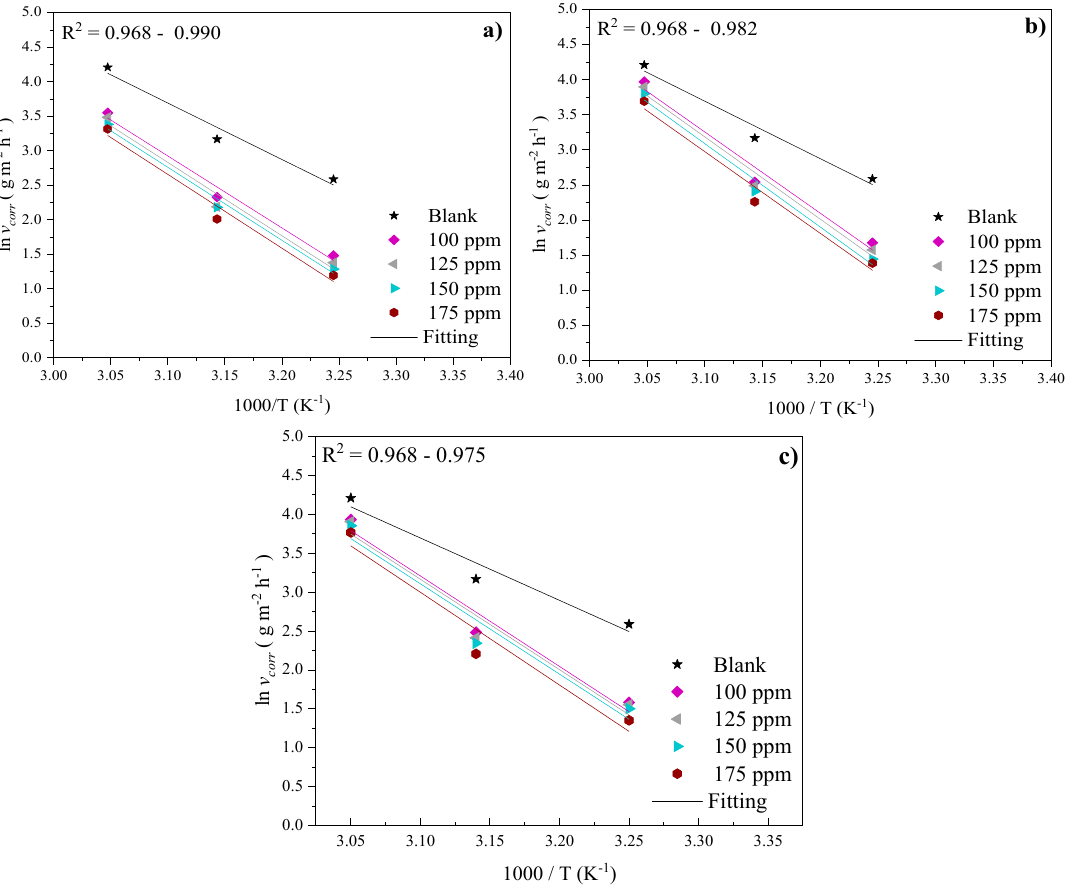
where v corr represents the corrosion rate in g m − 2 h − 1 calculated with i corr values [68] and A is the Arrhenius pre-exponential factor. The kinetic parameters E a and A were obtained from the slope and ordinate of the origin in Figure 13, respectively. Figure 12. Van’t Ho ff plot of API 5L X60 steel exposed to 1 M H 2 SO 4 —CIs. The negative values of ∆ H° ads for the H 2 SO 4 —CI system indicate not only that the adsorption process of Poly[VIMC4][Im], Poly[VIMC2][Br] and Poly[VIMC4][Br] had an exothermic nature, which is characteristic of physical adsorption [65], but also that the spontaneity of the adsorption process is limited by the temperature and that the protection of the metallic surface was favored at 298 K. On the other hand, the negative value of ∆ S° ads reveals that the inhibiting molecules present in the acid-inhibitor electrolytic solution are adsorbed orderly on the surface [66]. The temperature e ff ect on the corrosion inhibition of steel in the presence and absence of PILs can also be studied from the kinetic point of view by employing the Arrhenius equation shown in Equation (8). The activation energy ( E a ) is the energy that is necessary for a chemical reaction to be carried out and is related to the corrosion rate [67]: